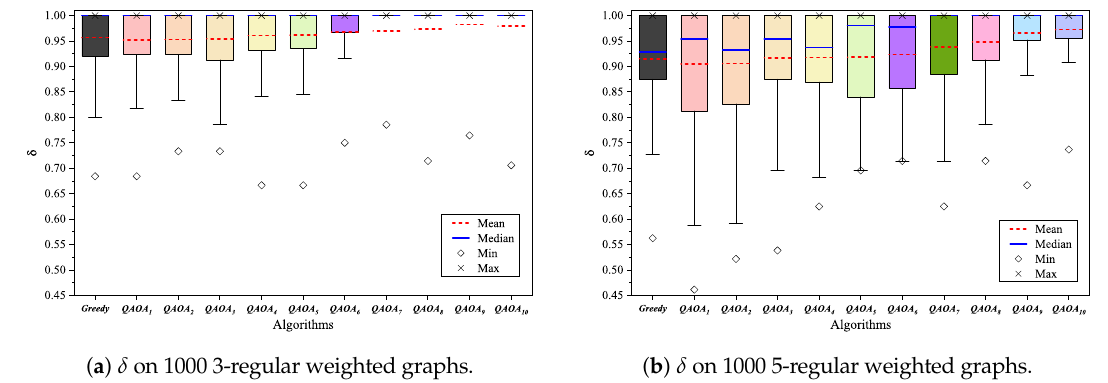
Figure 6. Approximation ratio δ of each algorithm: the performance of MWIS-based clustering depends on the δ of each algorithm. As the circuit depth p increases, the mean of δ tends to increase.